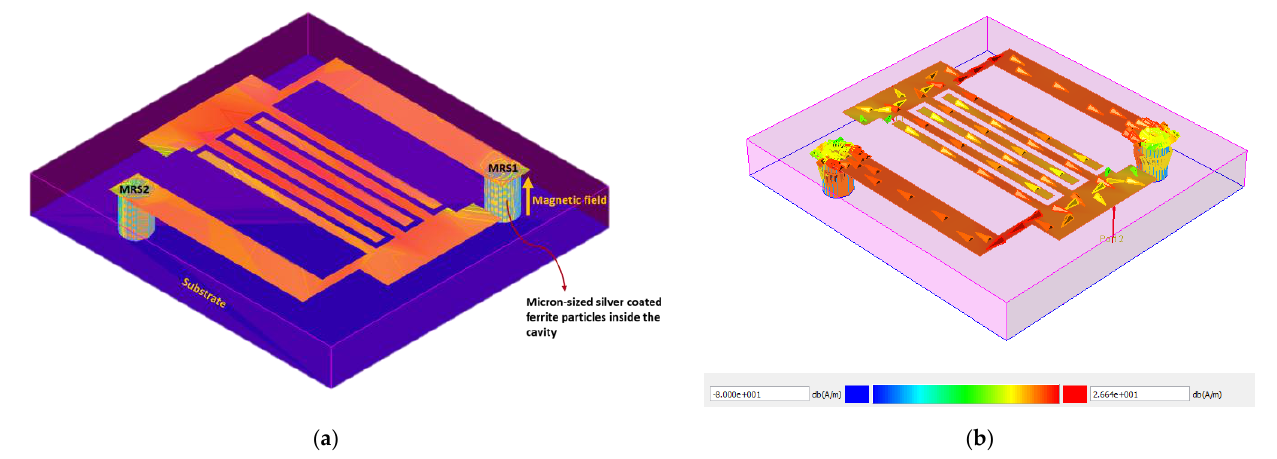
Figure 2. Isometric view of the proposed unit cell P-CRLH phase shifter with ( a ) magnetic alignment of particles in Magneto-static field Responsive Structures (MRSs); ( b ) Surface current distribution at 5.5 GHz when particles inside the MRS are activated. ( a )